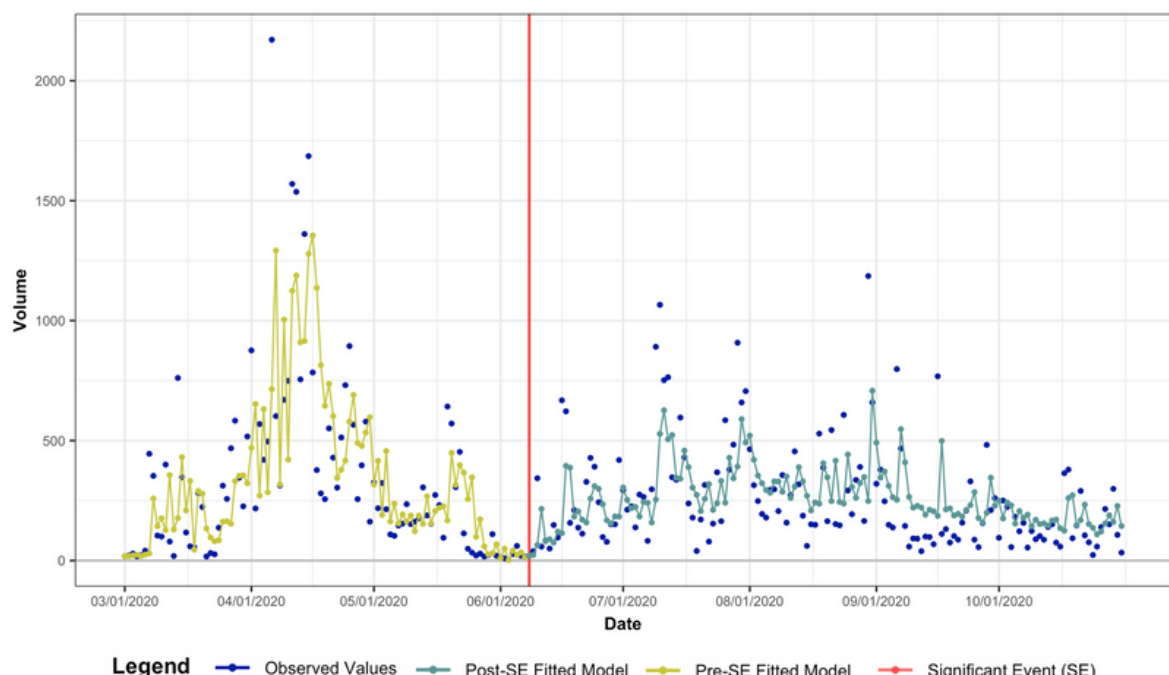
Figure 6. Plot of ARIMA Models before and after heightened border restrictions.